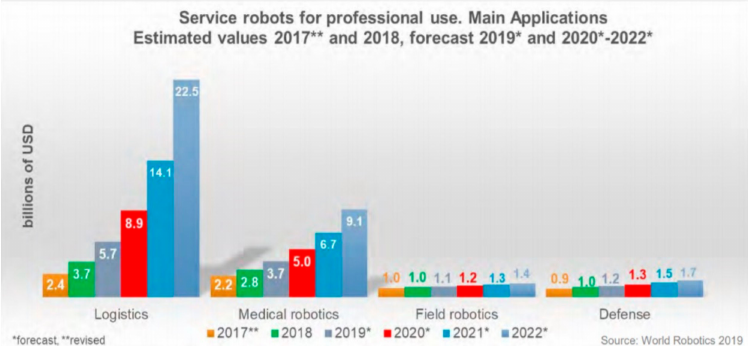
Figure 3. Increasing demand for medical robots in the world market